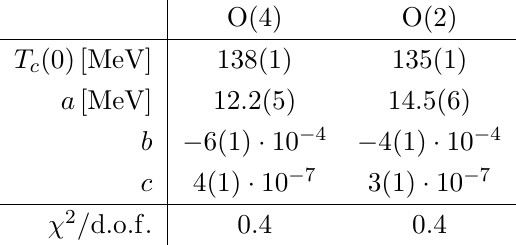
Table 3 . The parameters of a (cid:12)t to the T c ( m ) data using the function of eq. (4.2), with u chosen according to the indicated critical behavior.